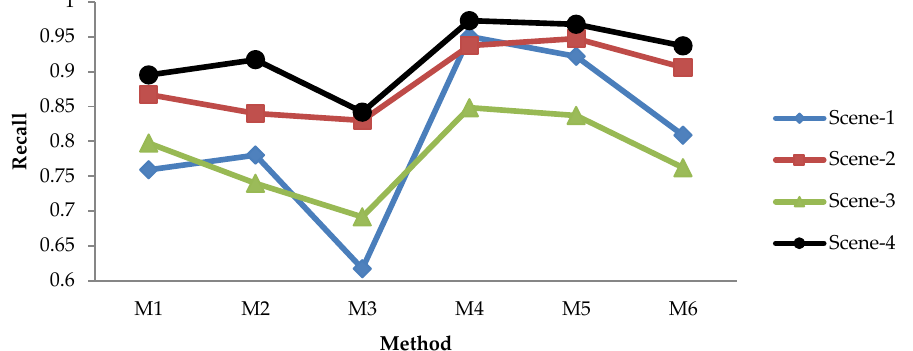
Figure 9. Recall of static image methods from four scenes.